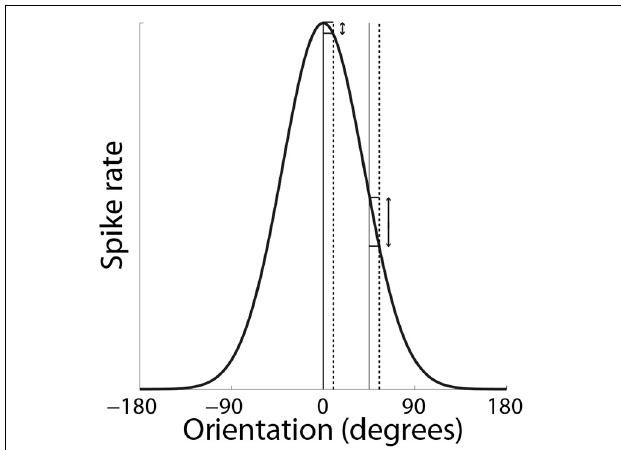
FIGURE 8 | SAT mechanism hypothesized by Ho et al. (2012). Small changes to a stimulus feature do not elicit much change in the response by neurons that are highly selective for the feature (on-target neurons). Here, the feature is orientation. The solid and dashed vertical lines on the left correspond to feature values of 0 ◦ and slightly greater than 0 ◦ respectively. The change in response by a neuron maximally responsive to 0 ◦ is shown by the corresponding horizontal lines abutting the black curve. The solid and dashed vertical lines on the right correspond to feature values of 45 ◦ and a slight increase from 45 ◦ respectively. The change in response by the same neuron (maximally responsive to 0 ◦ ) is shown by the corresponding horizontal lines abutting the black curve. For a given change in feature value, the difference in the off-target response is greater than the difference in the on-target